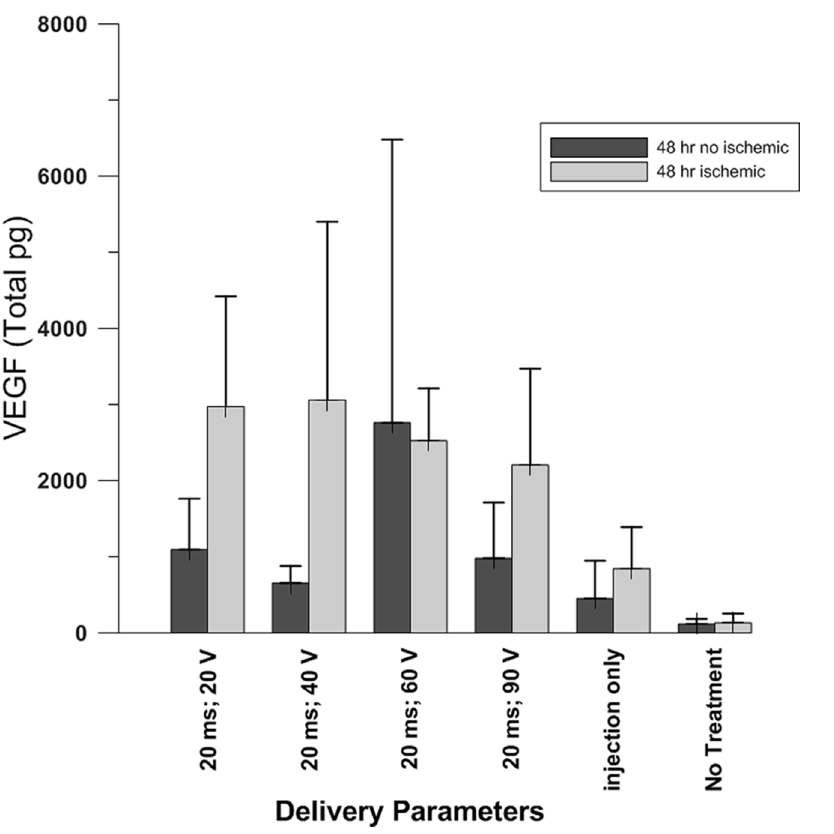
Fig. 2. Intra-cardiac delivery of pVax1-hVEGF 165 . The duration of intra-cardiac delivery of pVax1-hVEGF 165 was 20 milliseconds at varying voltages. Plasmid expression was significantly greater in the ischemic hearts with parameters 20 milliseconds; 20 V (p , 0.03 non- ischemic versus ischemic), 20 milliseconds; 40 V (p , 0.05 non- ischemic versus ischemic), and 20 milliseconds; 90 V (p , 0.05 non- ischemic versus ischemic), but not with the 20 milliseconds; 60 V parameter (p , 0.09 non- ischemic versus ischemic). The non-treated hearts had significantly less expression (p , 0.002) than the hearts treated with injection